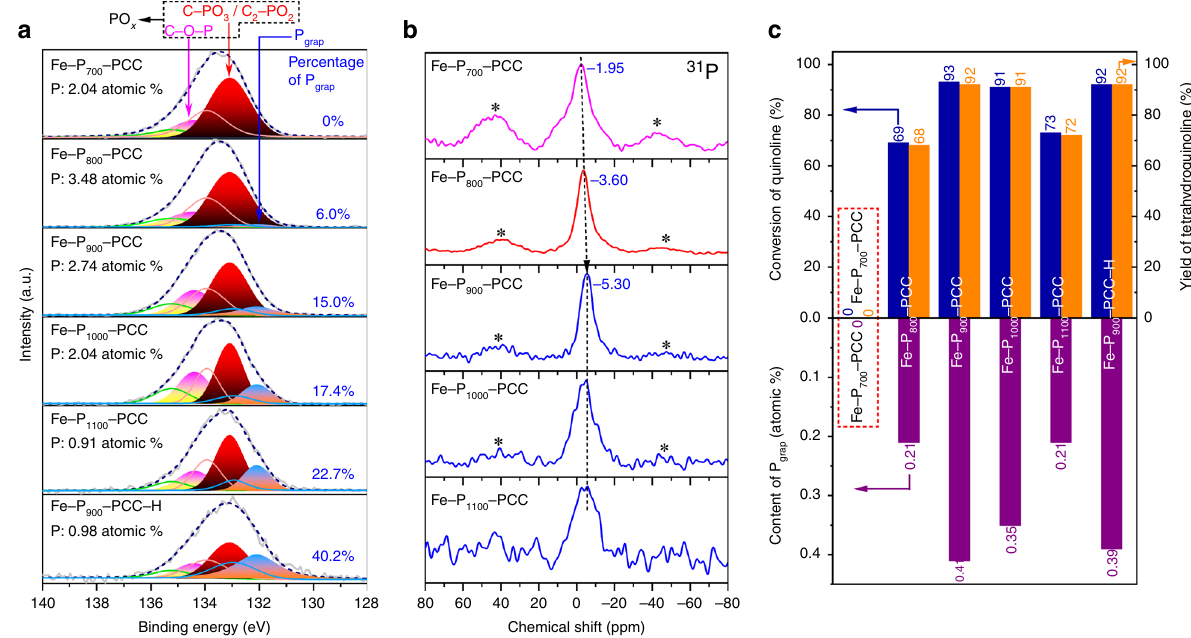
Fig. 2 Characterizations of P species. a Deconvoluted P 2p XPS spectra of Fe-P x -PCCs. All of the spectra were deconvoluted using three doublet peaks with an area ratio of 0.5 and a separation between peaks of 0.84 eV. b Solid-state 31 P NMR spectra of Fe-P x -PCCs. Spinning side bands are marked with asterisk. c The relationships between catalytic activity and content of P grap